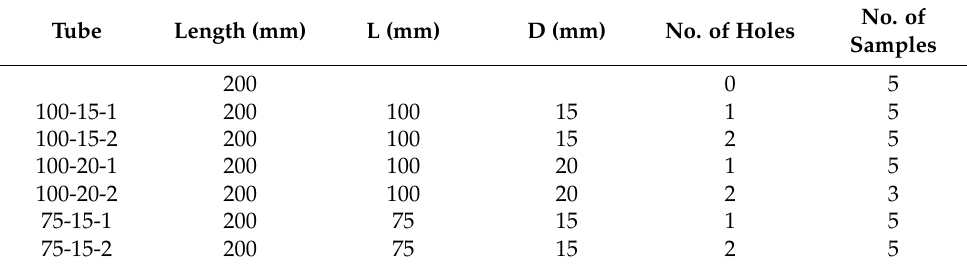
Table 2. Tube sample types and